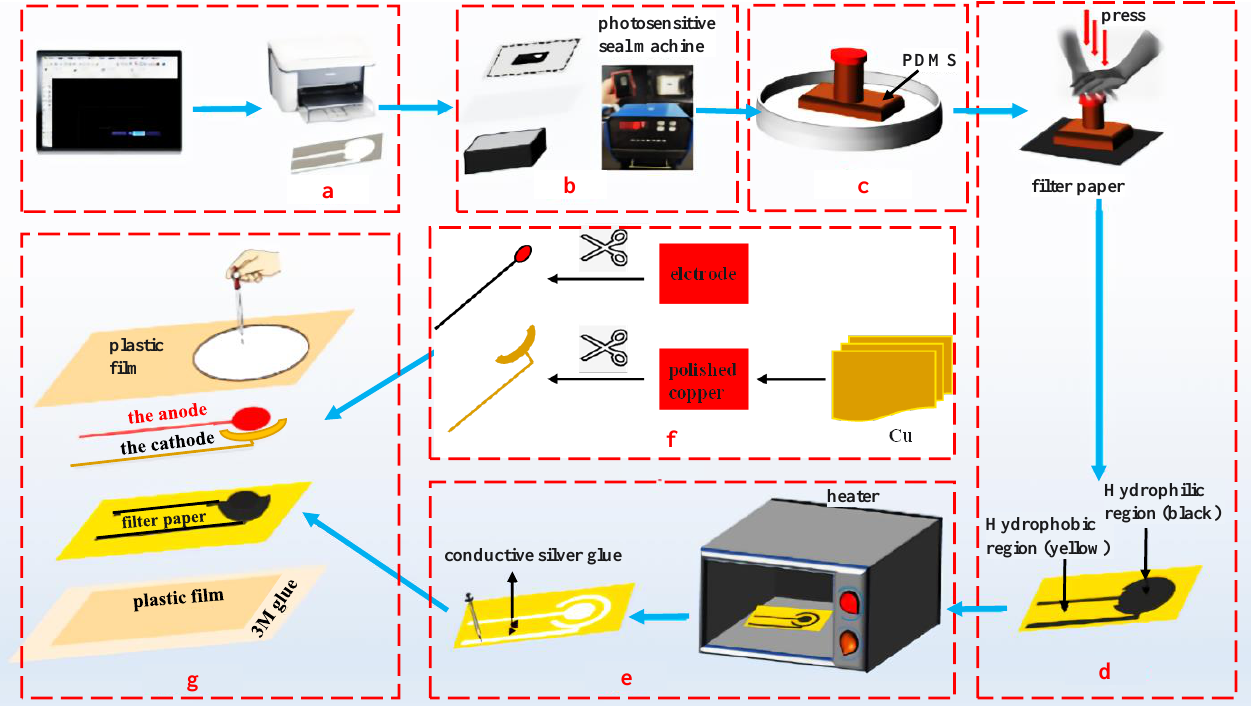
Figure 2. The fabrication process of the electrodes. ( a ) step 1: printing hydrophilic channels on the paper. ( b ) step 2: exposing the diagram. ( c ) step 3: immersing the stamp into PDMS. ( d ) step 4: stamping the pattern on the filter paper. ( e ) step 5: brushing the conductive silver glue. ( f ) step 6: fixing